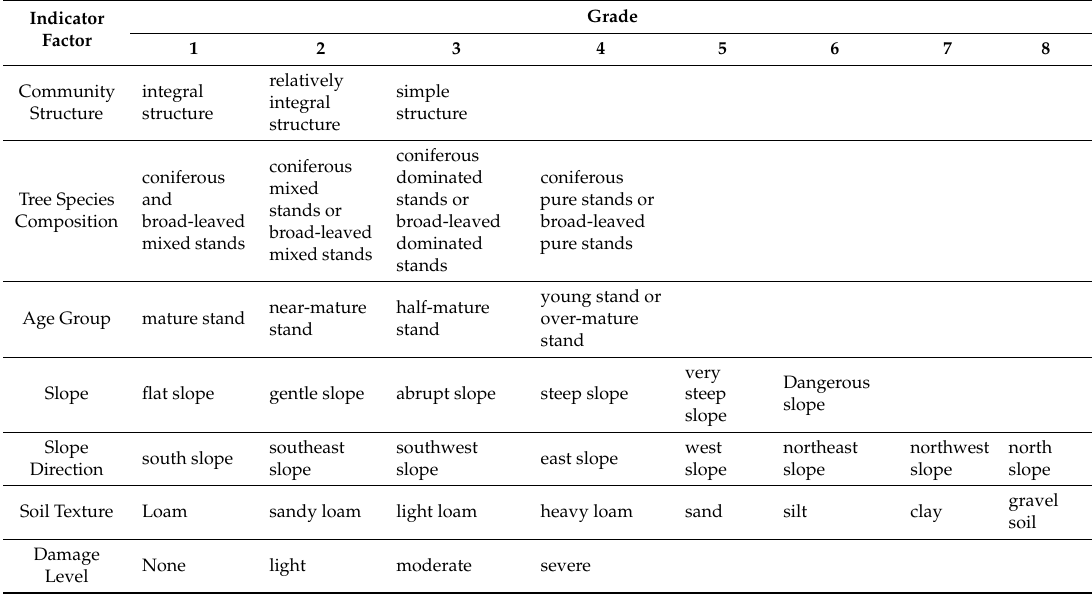
Table 4. Grade criteria of the qualitative indicators of the Mount Taishan forest ecosystem health